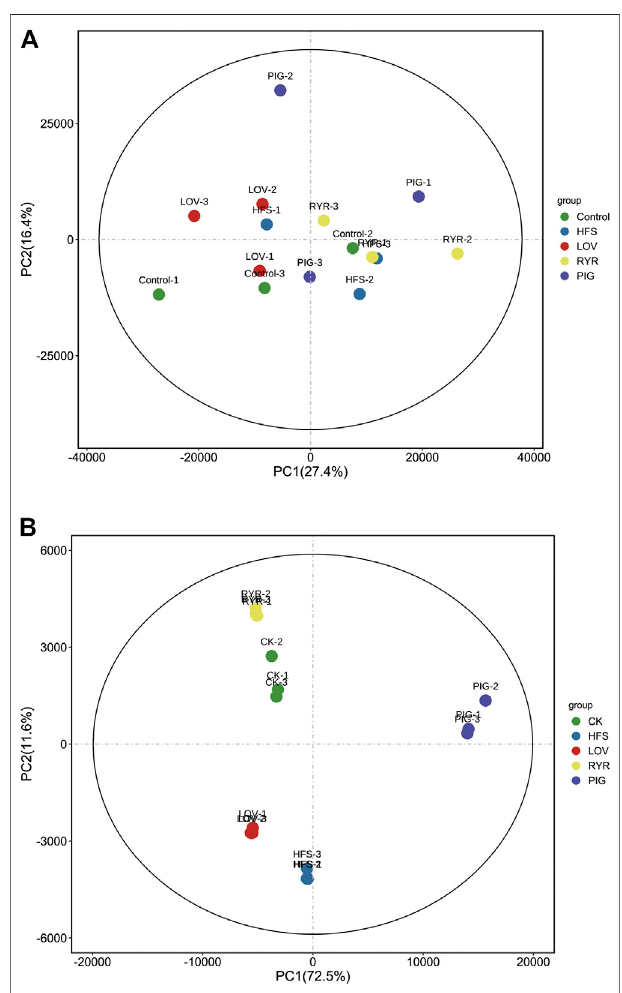
FIGURE 3 | Metabolic (A) and Gene (B) pro fi le of the CK, HFS, LOV, RYR,andPIGgroupsvisualizedbyprincipalcomponentanalysis(PCA)(n (cid:2) 3).